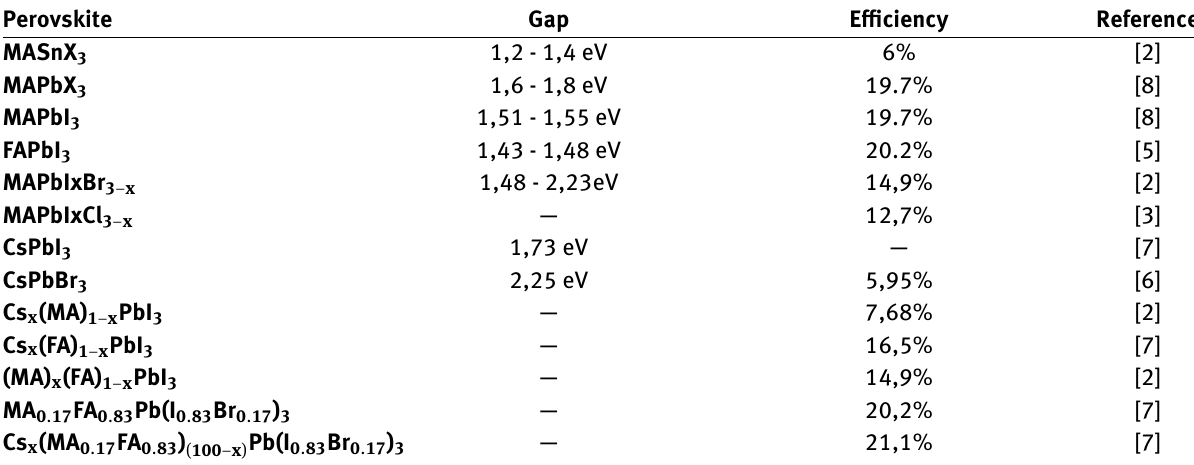
Table 1: Band gaps and eflciencies of solar cells based on the perovskite absorbers